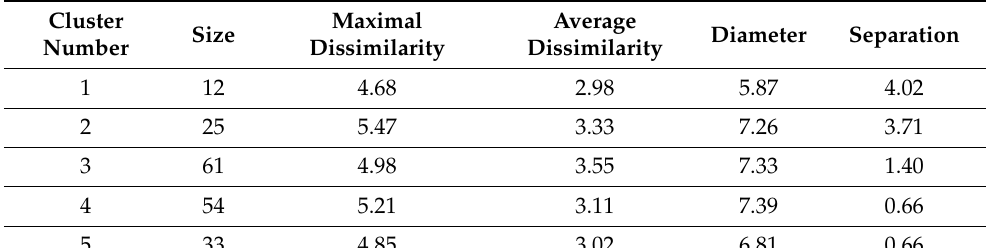
Table 1. Number of observations, cardinality, maximal and average dissimilarity of observations from each cluster, diameter and separation of clusters which were the result of k-medians method.